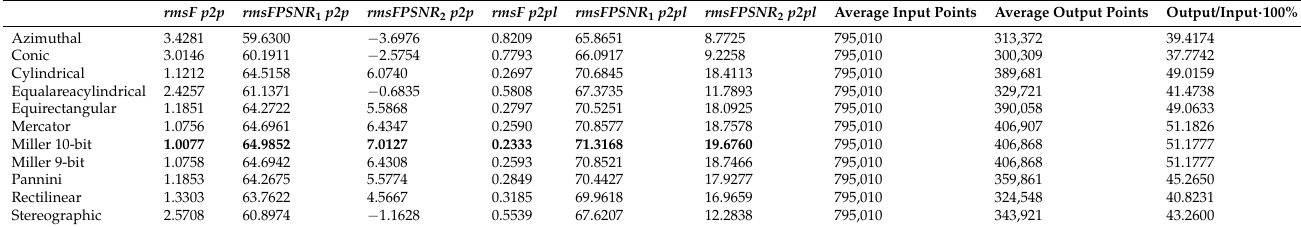
Table 5. Point-to-point (p2p) and point-to-plane (p2pl) objective measures rmsF , rmsFPSNR 1 and rmsFPSNR 2 , before Poisson reconstruction, using different projections with projection area of 1296 × 1160 pixels (approximately 1,500,000), best values are bold; average input and output number of points and their